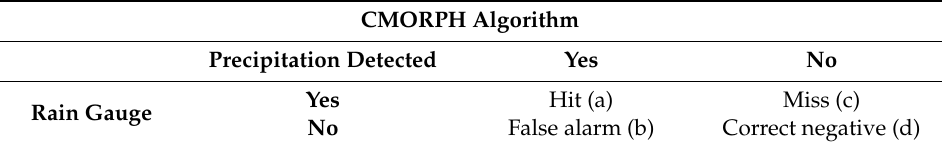
Table 2. Table of contingencies for the analysis of precipitation detection